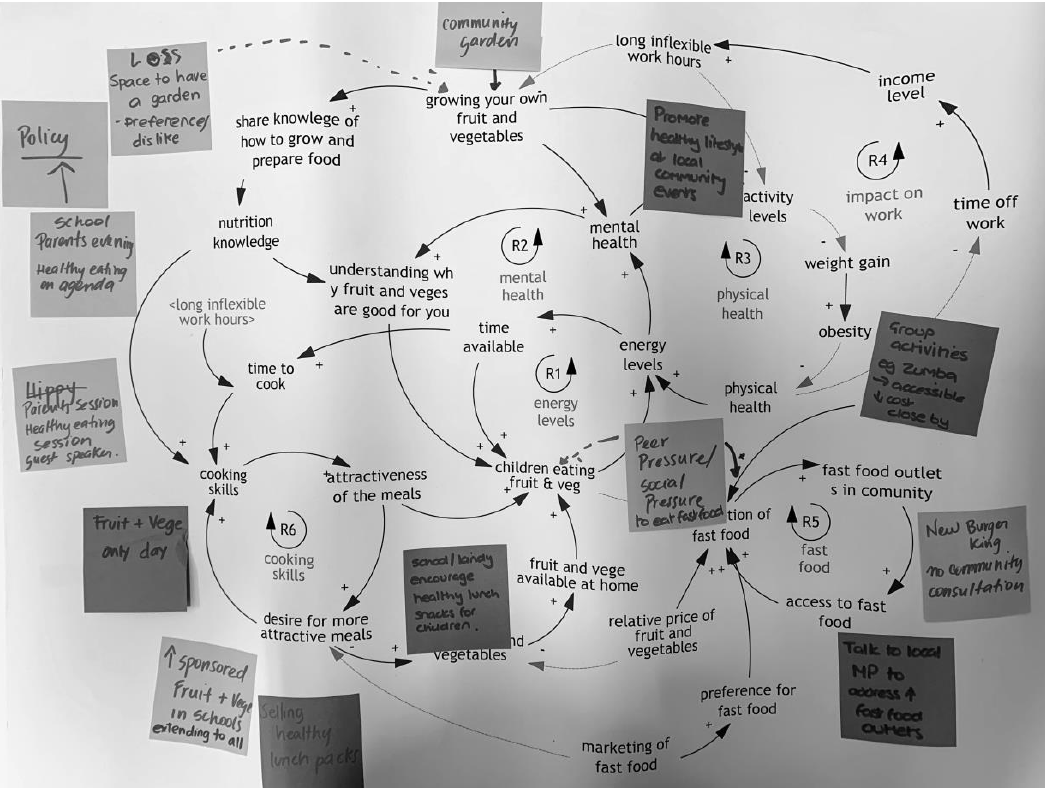
Figure 3. Example of actions placed on the collective causal loop diagram (CLD).